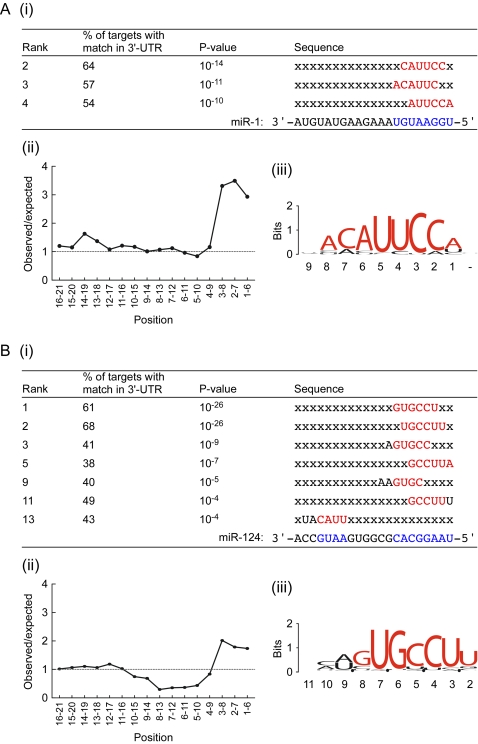
Significantly enriched motifs in 3′-UTRs of mRNAs targeted to Ago2 by miR-1 and miR-124.(A) Analysis of mRNAs associated with Ago2 from cells transfected with FLAG-Ago2 and miR-1 relative to cells transfected with Ago2 alone (1% local FDR). (i) Enrichment of hexamers in 3′-UTRs of miR-1 IP targets compared to 3′-UTRs of all mRNAs passing array filters. Shown are hexamers with at least four contiguous Watson-Crick base pairs to miRNA with a p-value cut-off of 0.001 (binomial test with bonferroni correction). Rank by p-value relative to all 4096 hexamers. Bases in red can form Watson-Crick base pairs with miR-1. (ii) Moving plot of observed/expected ratios of hexamers complementary to miR-1. Frequencies calculated as in (i). (iii) 10mer motif returned by MEME motif finder using 3′-UTR sequences from the miR-1 high confidence target set. For each position in the motif, the combined height of the bases represents the information content at that position, whereas the relative heights of the individual bases represent the frequency of that base at that position. Bases in red can form Watson-Crick base pairs with miR-1. Numbers underneath the logo correspond with miRNA 5′-position, with 1 being the 5′-most miRNA nucleotide. (B) Same as in (A), except for mRNAs associated with Ago2 from cells transfected with FLAG-Ago2 and miR-124 relative to cells transfected with Ago2 alone.